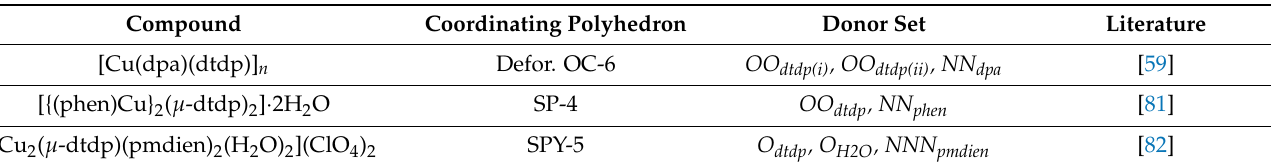
Table 3. Structurally characterized copper complexes with 3,3 1 -dithiodipropionic acid and N donor ligands.